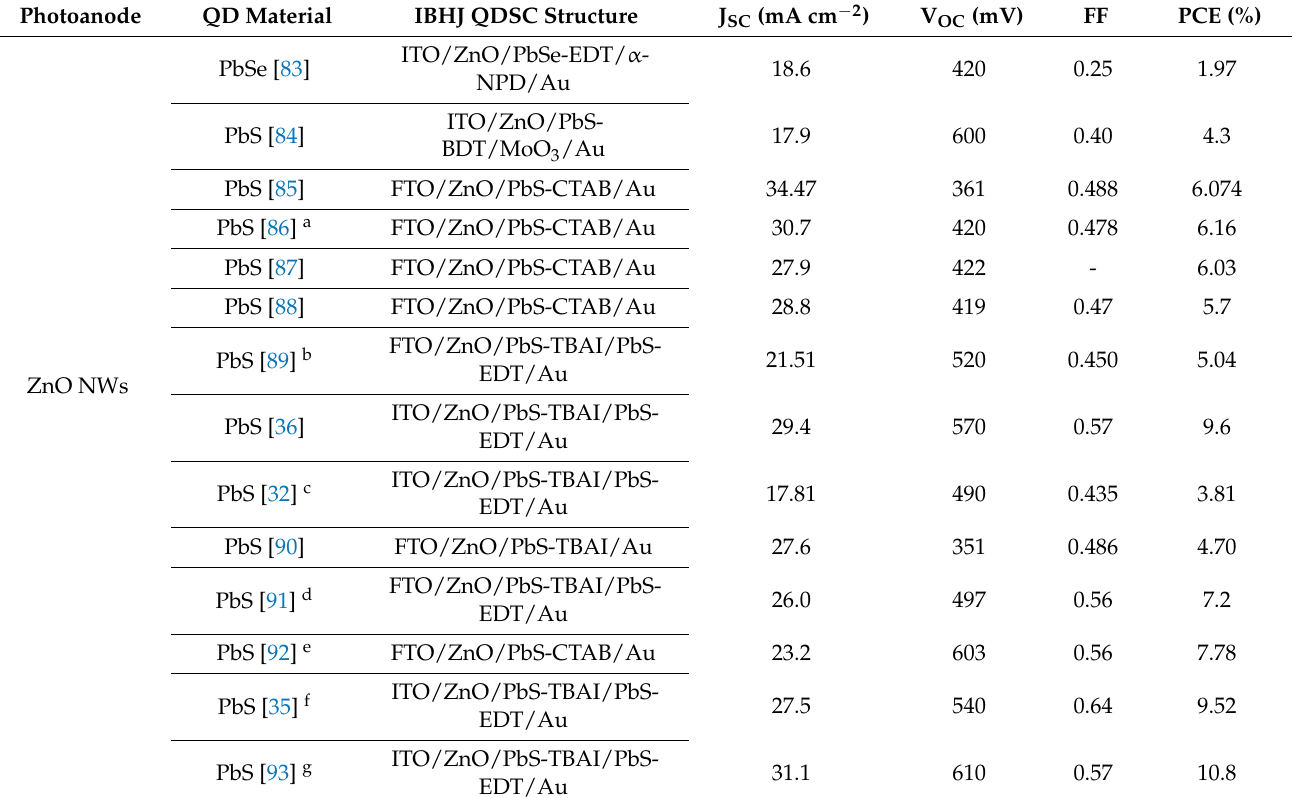
Table 2. PV performances of the QDSCs integrating ZnO NW